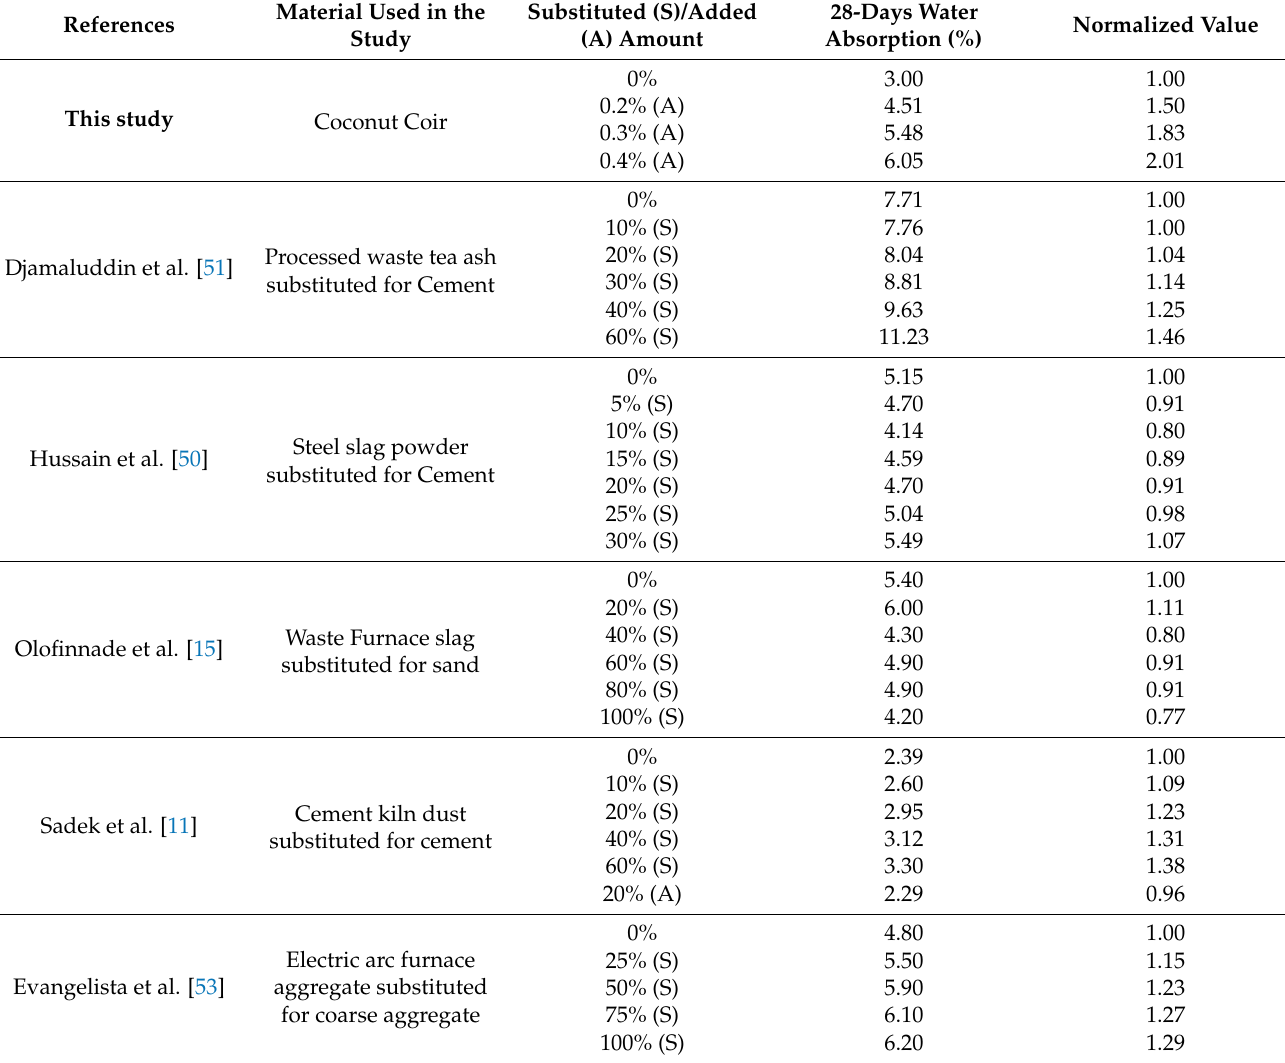
Table 13. Comparison of Water Absorption of IPB’S with various